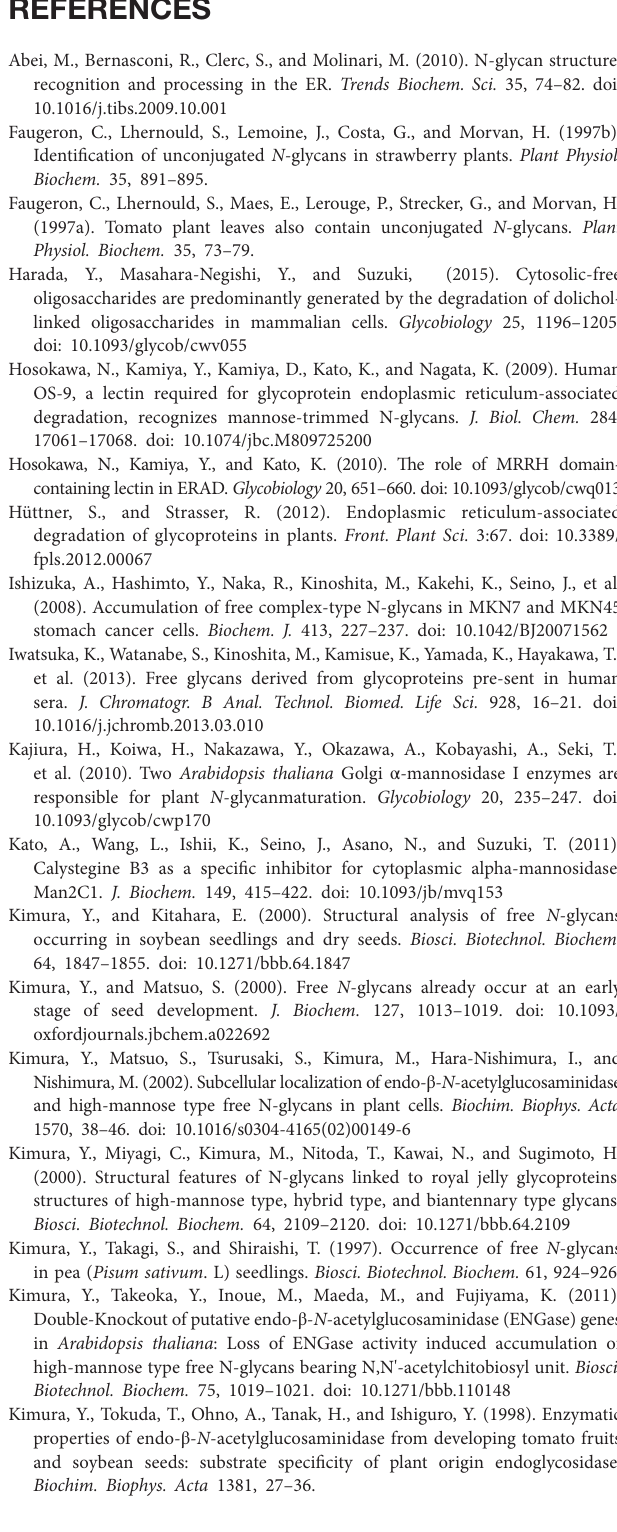
Supplementary Figure 2 | ESI-MS analysis of peak c obtained from F1 (as obtained in Figure 2-II ). (I) ESI-MS analysis of peak c obtained in Figure 2-II . (II) MS/MS analysis of a signal at m/z 879.8 [M + 2H] 2+ .